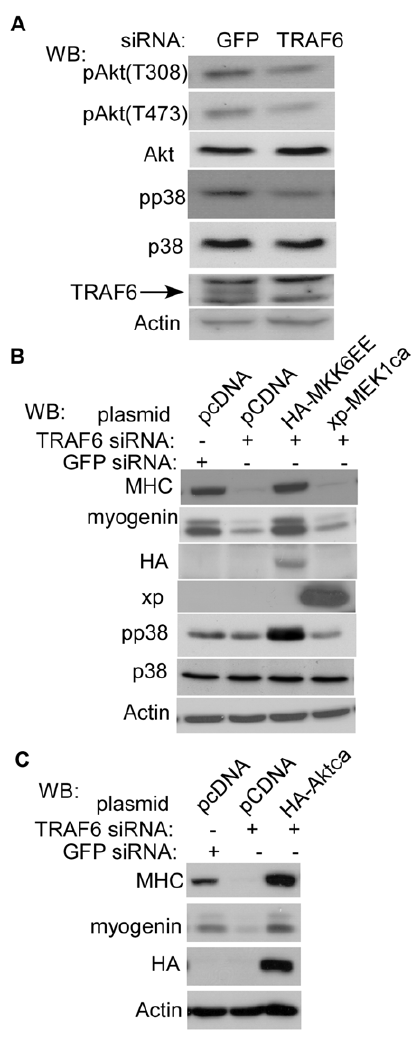
Figure 5. Both p38 MAPK and Akt mediated the effect of TRAF6 during myogenic differentiation. (A–C) C2C12 cells were transfect- ed with the GFP-siRNA or TRAF6-siRNAs with or without various cDNA expression vectors as indicated. (A). Cells were harvested 24 hours after transfection. (B, C) Twenty-four hours after transfection, cells were induced to differentiate in DM for another 36 hours before harvest. WCEs from (A–C) were subjected to SDS-PAGE and Western blot analysis for various proteins as indicated. MKK6EE, MEK1ca and Aktca are the constitutively active mutants of MKK6, MEK1, and Akt respectively. xp: